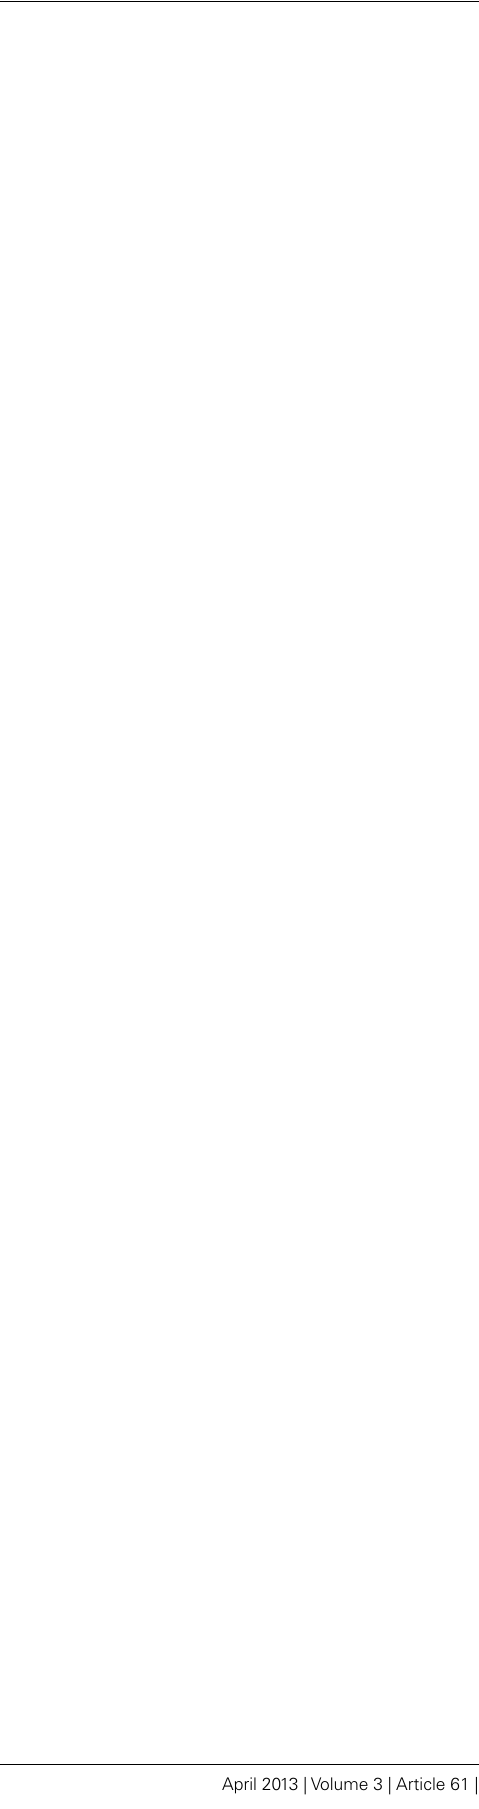
Frontiers in Oncology | Molecular and Cellular